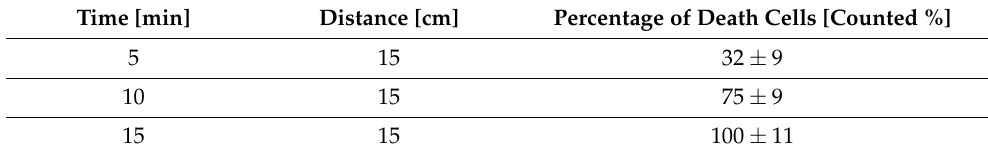
Table 3. Results of optimization of the irradiation time of prostate cancer tissue with a